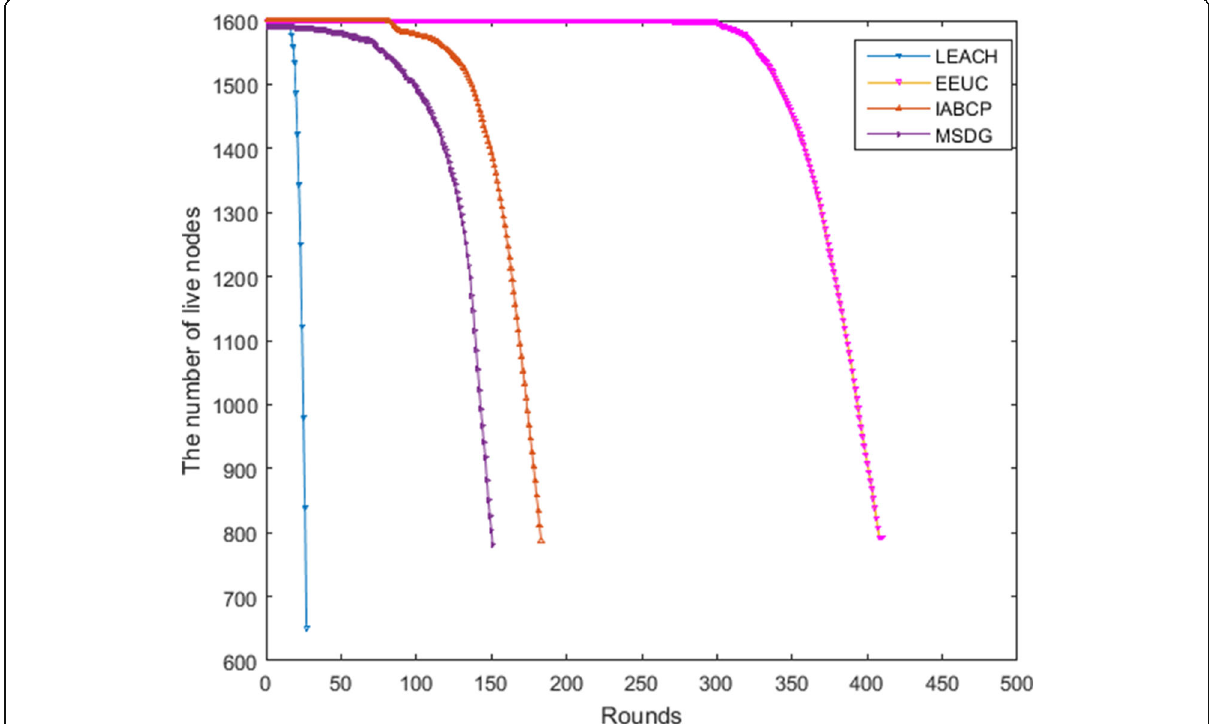
Fig. 8 Protocol life comparison. It can be seen that this protocol has the longest service life, followed by EEUC protocol, and LEACH protocol has the shortest service